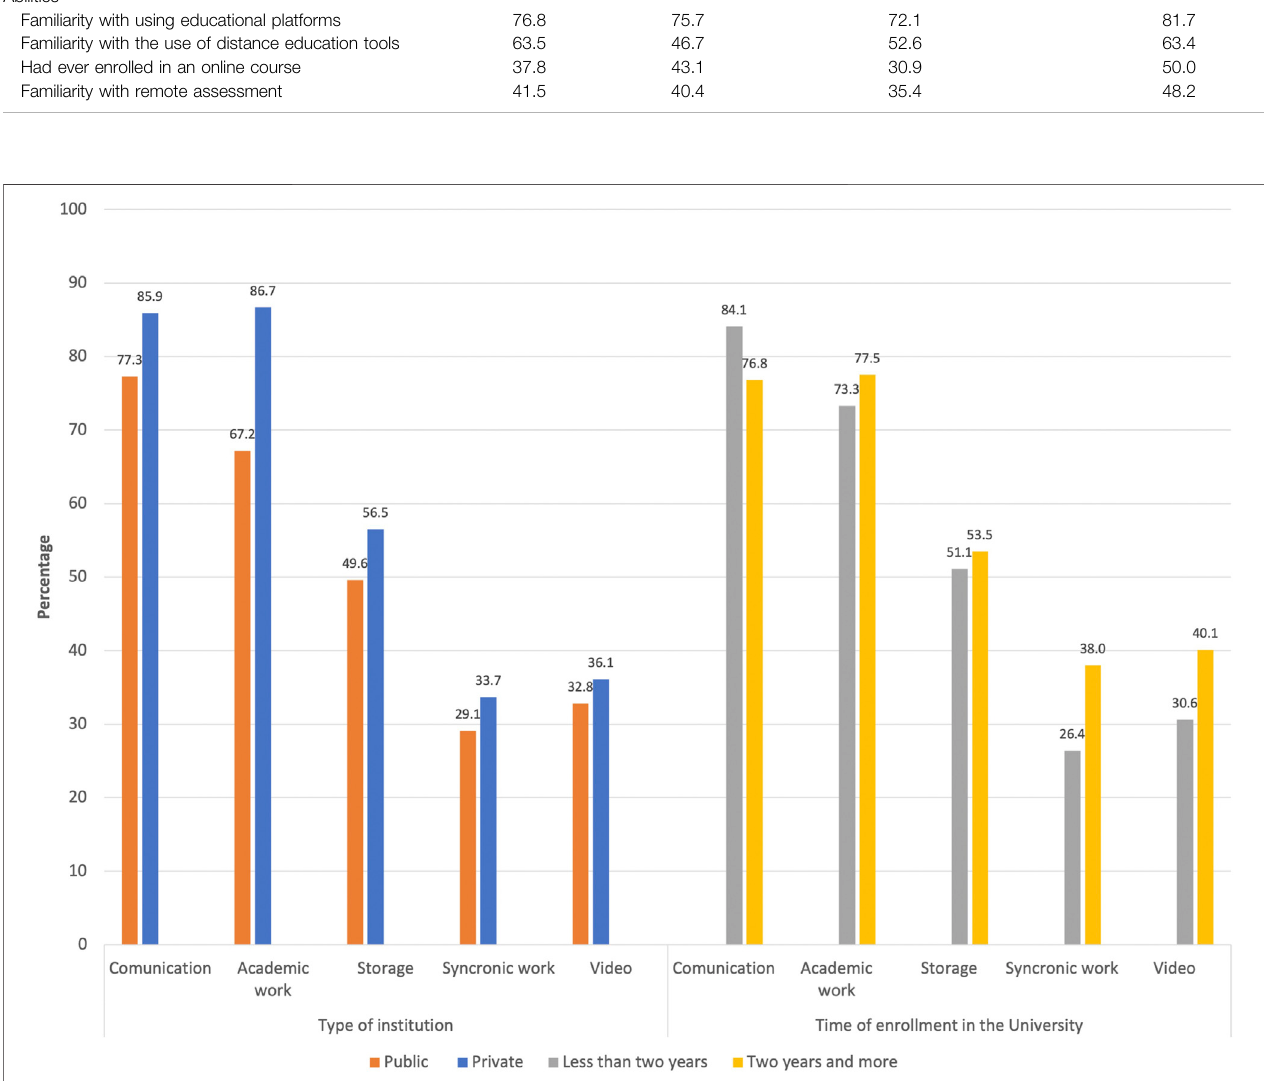
Frontiers in Education |